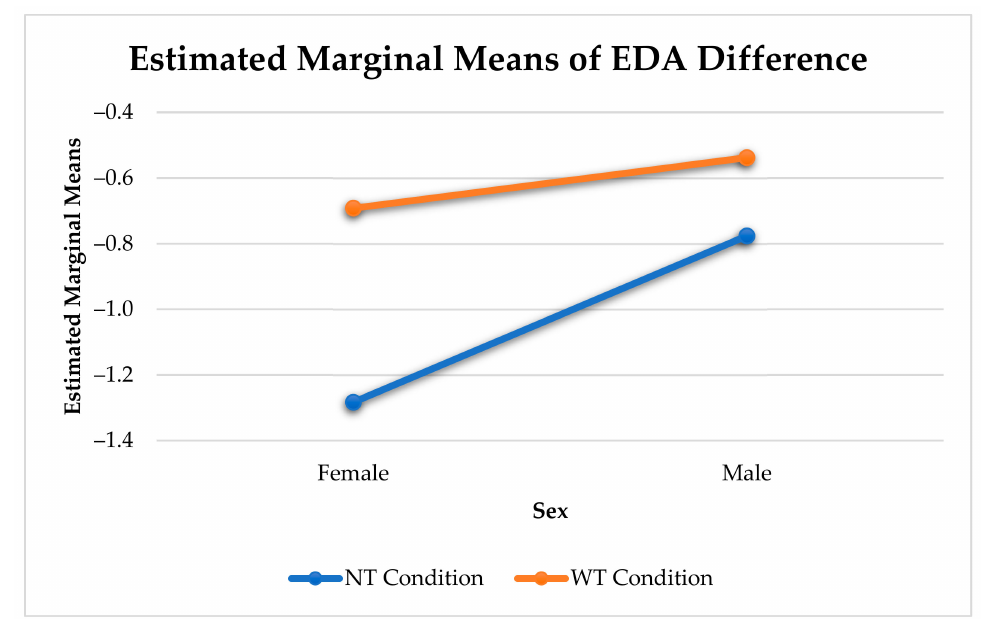
Figure 13. Sex Differences in Physiological Arousal Change Elicited by Utterances with or Without Non-Affective